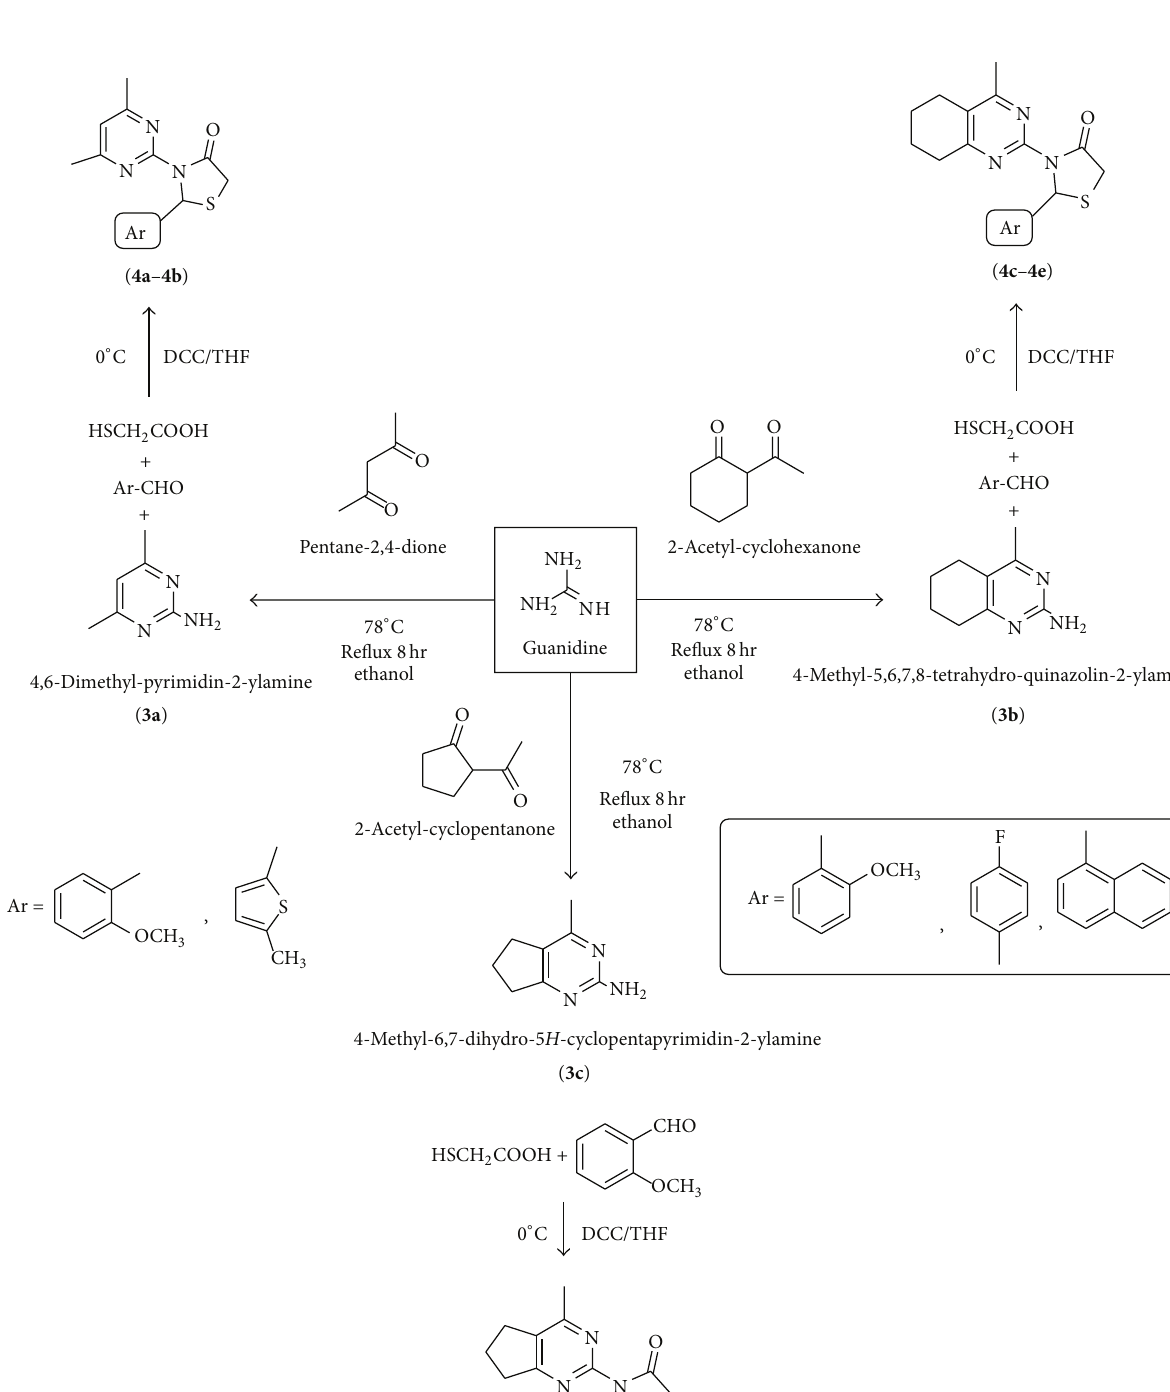
Figure 1: Synthetic pathway for the compounds ( 4a – 4f